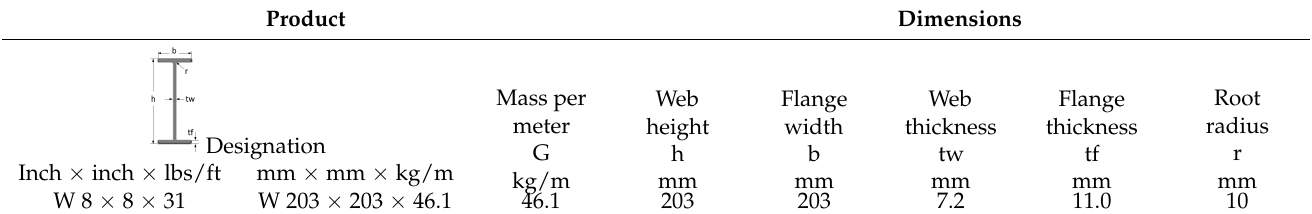
Table 1. Typical details of the examined I-beam (W-shape: W 203 × 203 × 46.1).